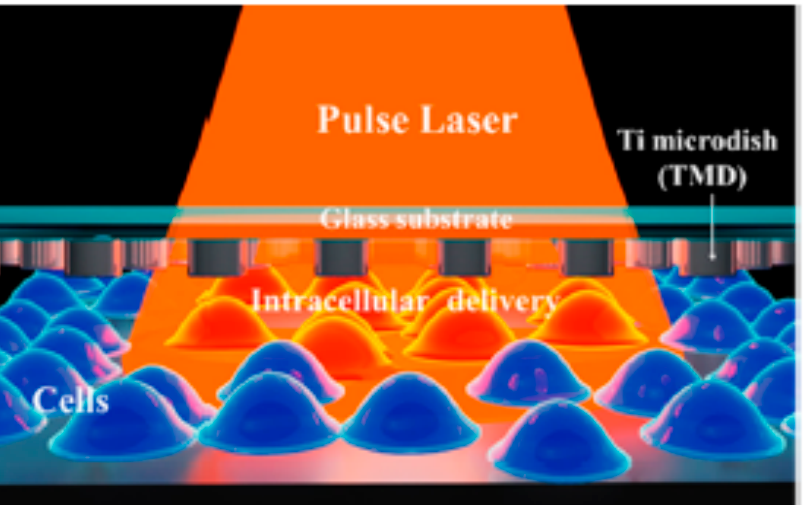
Figure 19. Schematic of the parallel high-throughput intracellular delivery platform using the photoporation technique. A TMD microdevice was exposed to a pulse laser with an Infrared (IR) wavelength and photothermal cavitation bubbles were generated to disrupt the plasma membrane and deliver biomolecules into the cells. Reprinted with permission from ref. [129]. Copyright © 2020 American Chemical Society.